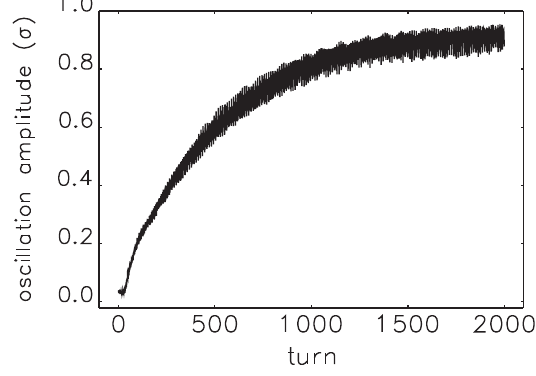
FIG. 4. Vertical instability amplitude for the baseline simulation.